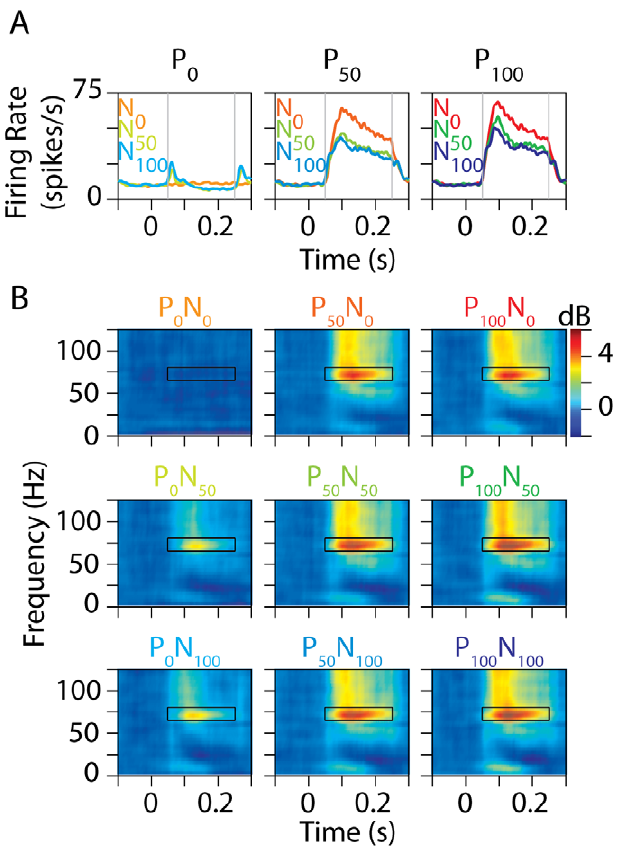
Figure 3. Gamma power depends on normalization. (A) Average firing rate of 96 MT neurons from two animals when two stimuli—one moving in the preferred direction and the other in the opposite (null) direction—were presented in the receptive field while the monkeys attended to a third stimulus outside the receptive field. The preferred and null stimuli were presented at 0%, 50%, or 100% contrast, yielding nine stimulus configurations. Each plot shows the data for a fixed value of the preferred contrast: 0% (i.e., no preferred stimulus; left panel), 50% (middle), or 100% (right). The different colored lines in each plot each represent a different null contrast: 0% (red; lower preferred contrasts have a lighter shade), 50% (green), or 100% (blue). The stimuli were presented for 200 ms. Firing rates were computed between 50 and 250 ms (gray lines). (B) Time-frequency power difference spectra, which represent the change in power relative to a prestimulus baseline (100 ms immediately before stimulus onset) for the nine stimulus conditions. Gamma rhythm was computed between 50 and 250 ms at 65 and 80 Hz, indicated by a black box in each plot.